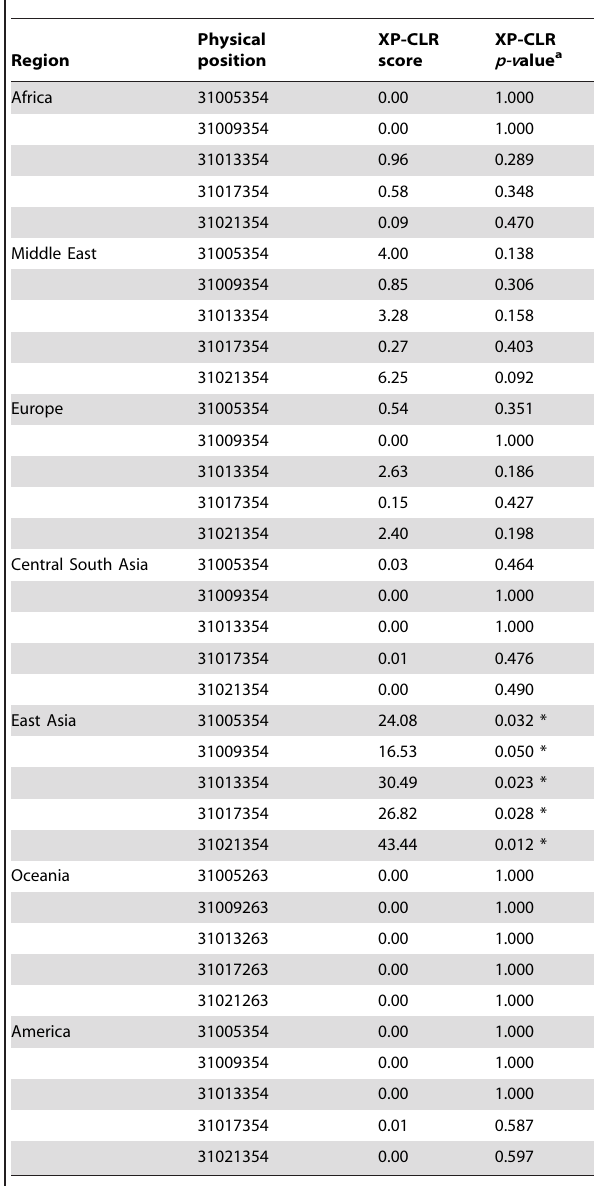
Table 2. Results of the XP-CLR test in a 16 kb region centered on VKORC1 in the seven geographic